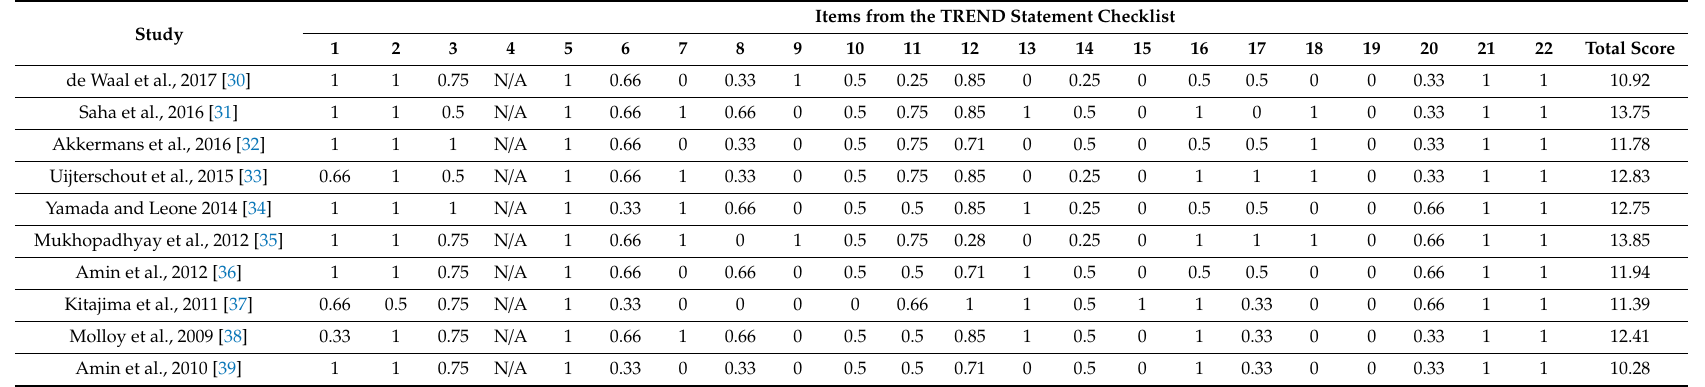
Table 2. Score breakdown on 22 items from the Transparent Reporting of Evaluations with Non-randomized Designs (TREND) Statement Checklist for each non-randomized